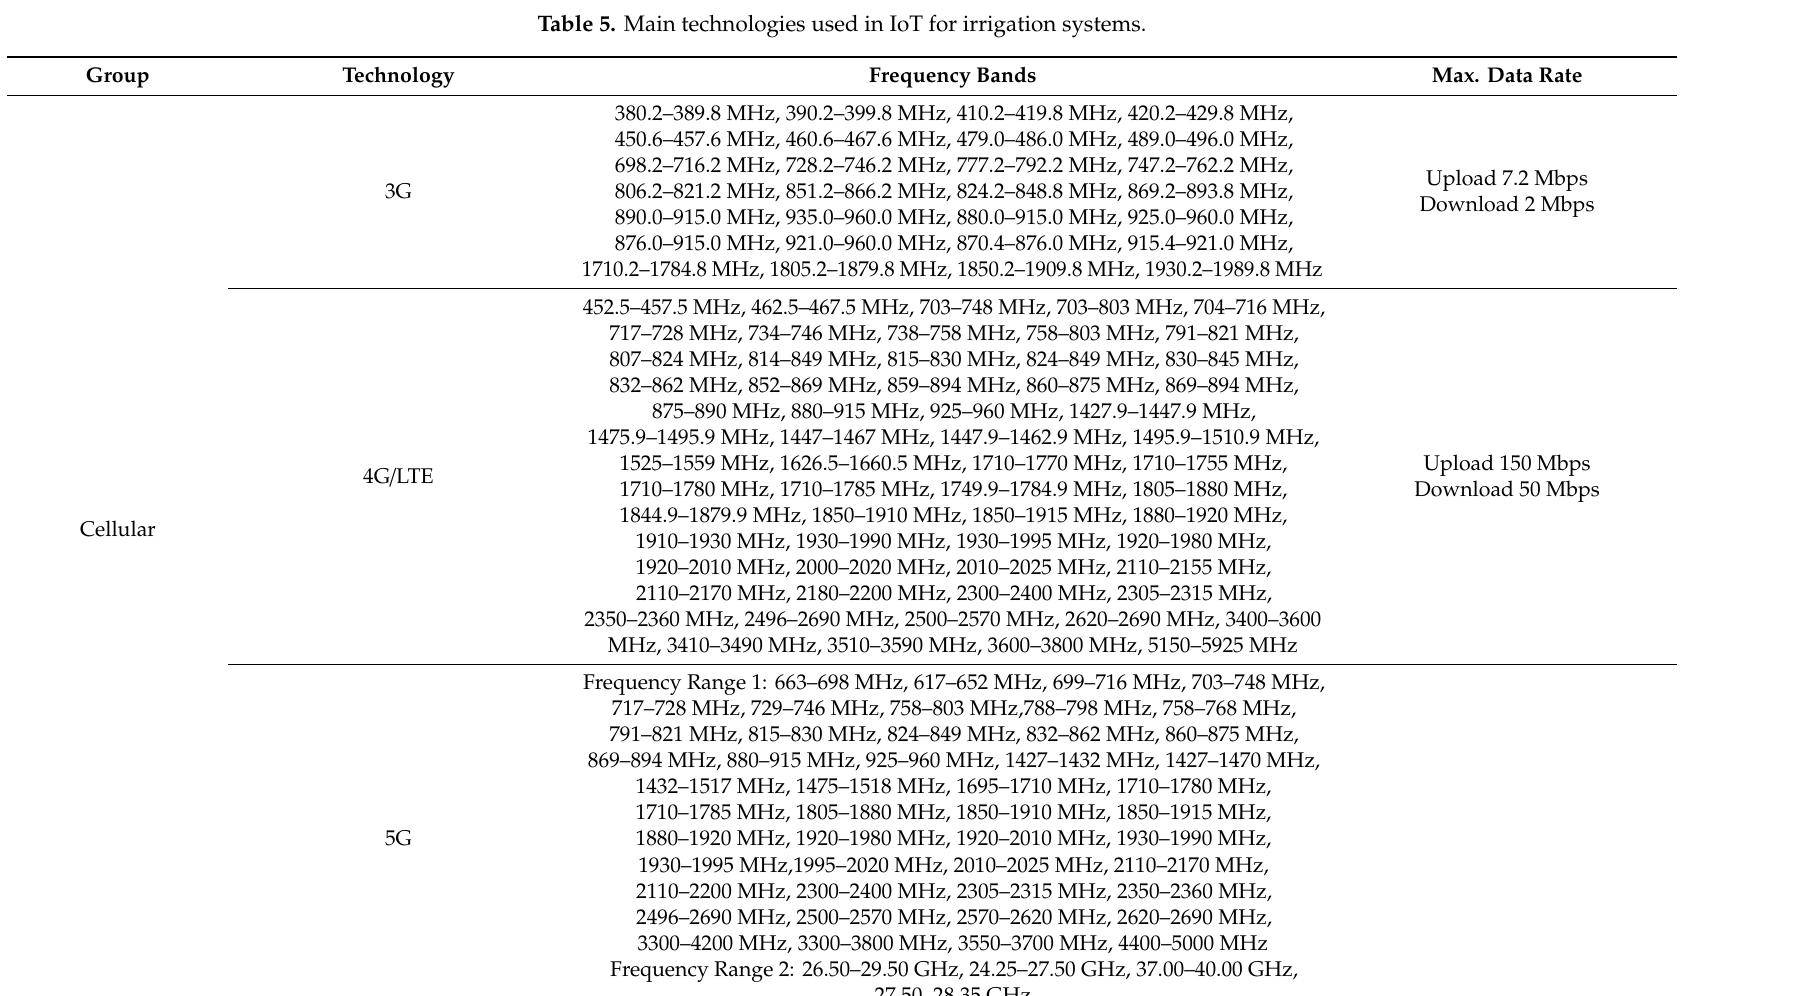
Table 5. Main technologies used in IoT for irrigation